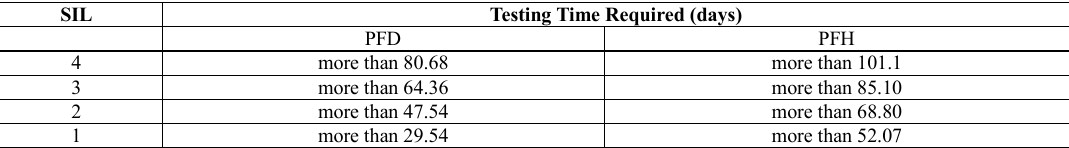
Table 1. Estimated testing time required at least for conforming